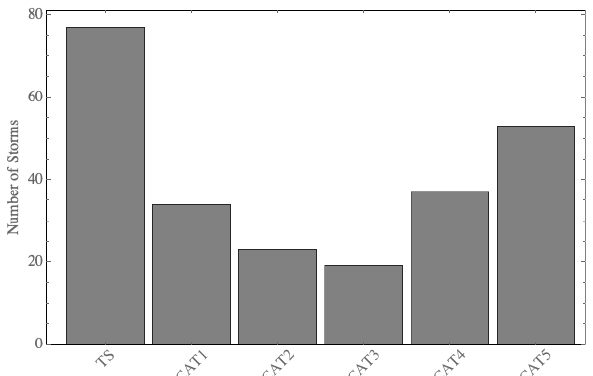
Figure 9. Divisions of the storm strengths after downscaling the results from the hurricane model. Abbreviations in figure are as follows: TS—Tropical storm, CAT1—Category 1, CAT2—Category 2, CAT3—Category 3, CAT4—Category 4, CAT5—Category 5.